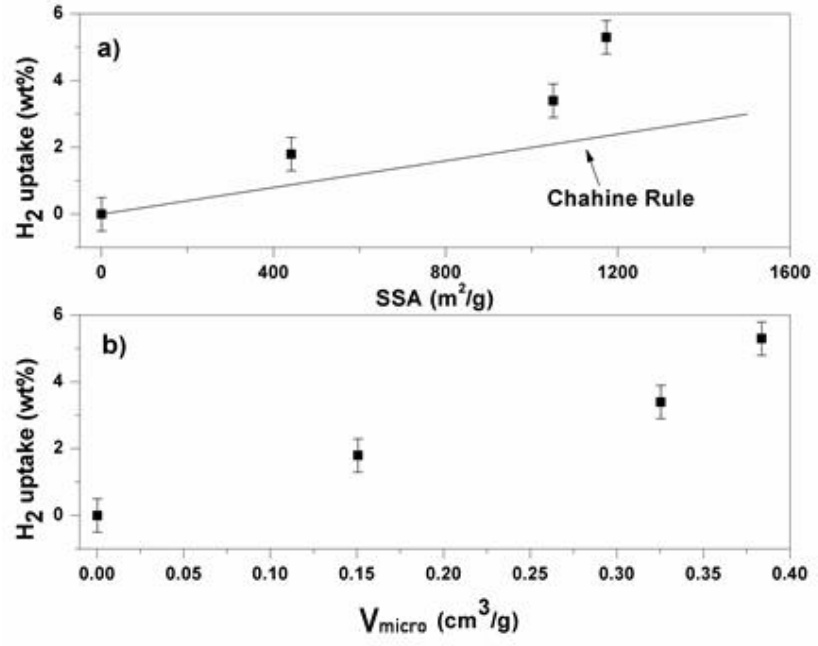
Figure 10. ( a ) H 2 uptake at 80 bar and 77 K vs. SSA. ( b ) H 2 uptake at 80 bar and 77 K vs. V micro .